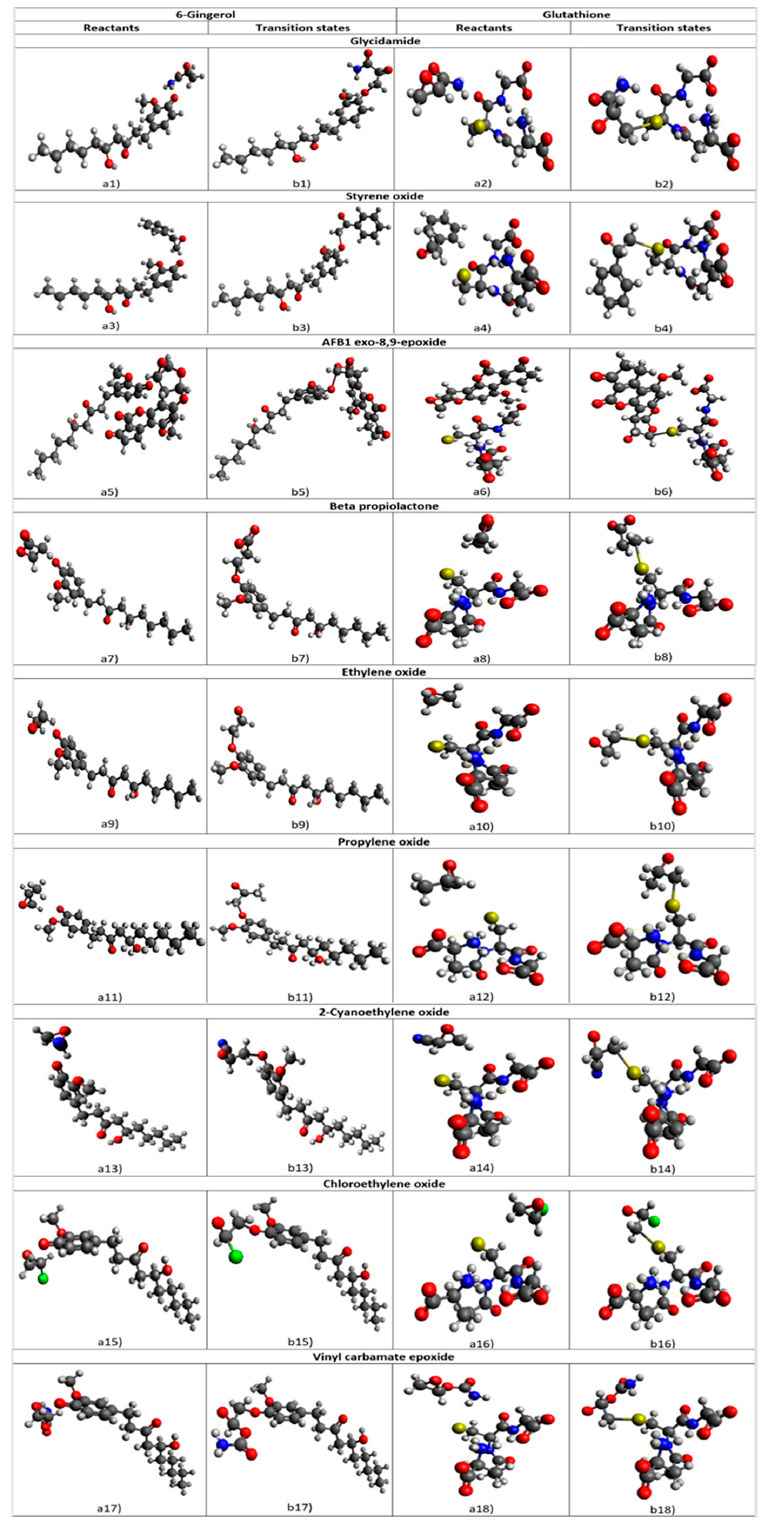
Figure 3. The structures of the reactant states ( a1 – a18 ) and the transition states ( b1 – b18 ) for the nucleophilic attack of the phenolic oxygen atom of [6]-gingerol and the sulfur atom of glutathione through the alkylation reaction with the nine studied ultimate chemical carcinogens as predicted by the Hartree-Fock (HF) method using the 6-311 ++ G(d,p) basis set. Carbon atoms are depicted in gray, oxygen atoms in red, nitrogen atoms in blue, sulfur atoms in yellow and hydrogen atoms in white